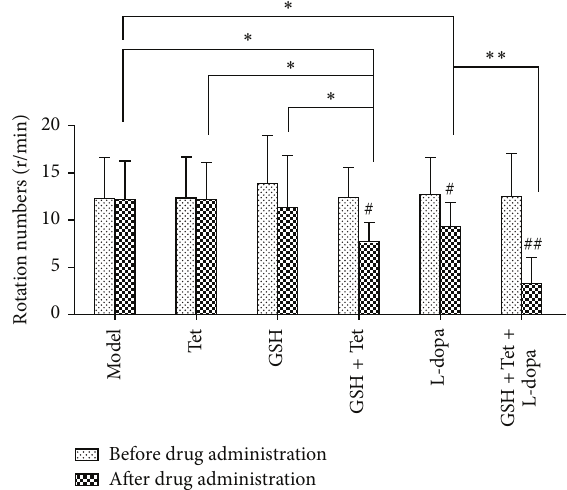
Figure 1: Changes in apomorphine- (APO-) induced rotational behavior of Parkinson’s disease (PD) rats after drug treatment. The number of contralateral rotational turns in 30min after intraperi- toneal (i.p.) APO administration was recorded. Each bar represents mean ± standard deviation (SD) for 14 animals per group. # 𝑝 < 0.05 , ## 𝑝 < 0.01 comparison within each group before and after drug treatment. ∗ 𝑝 < 0.05 , ∗∗ 𝑝 < 0.01 comparison among different groups after drug